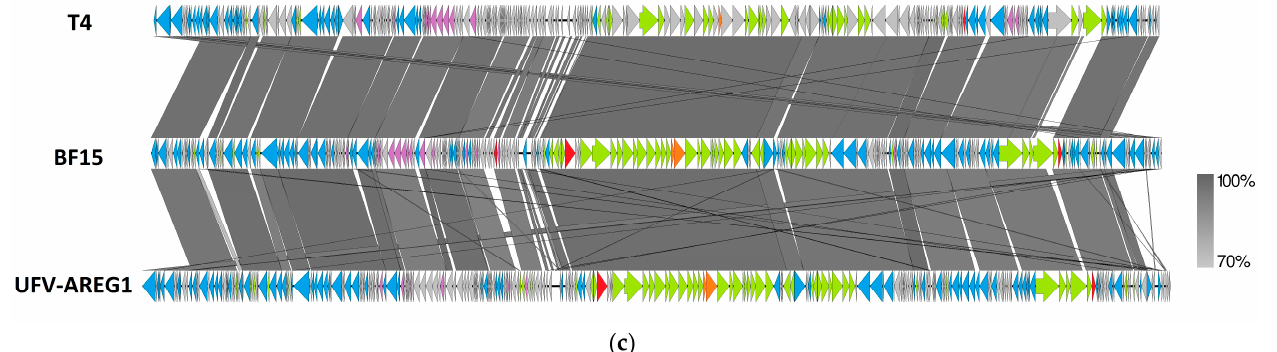
Figure 3. Genomic and phylogenetic analysis of bacteriophage BF15. ( a ) Phylogenetic tree of BF15 (in bold) generated by VICTOR using the whole-genome sequences of phage homologs in BLASTn. The numbers above branches are GBDP pseudo-bootstrap support values from 100 replications. ( b ) VIRIDIC heatmap based on intergenomic similarities between BF15 and closest homologs in BLASTn. The number in the chart represents the similarity percentage. ( c ) Genome comparison of BF15 with closely related members of the Tequatrovirus genus. The grey shading indicates sequence similarities between the genomes. The predicted functions of proteins are indicated by different colors: phage morphogenesis and virion structure (green arrows), DNA packaging (orange arrows), host lysis (red arrows), phage DNA replication and modification (blue arrows), and additional functions (purple arrows). Grey arrows represent ORFs of unknown functions.